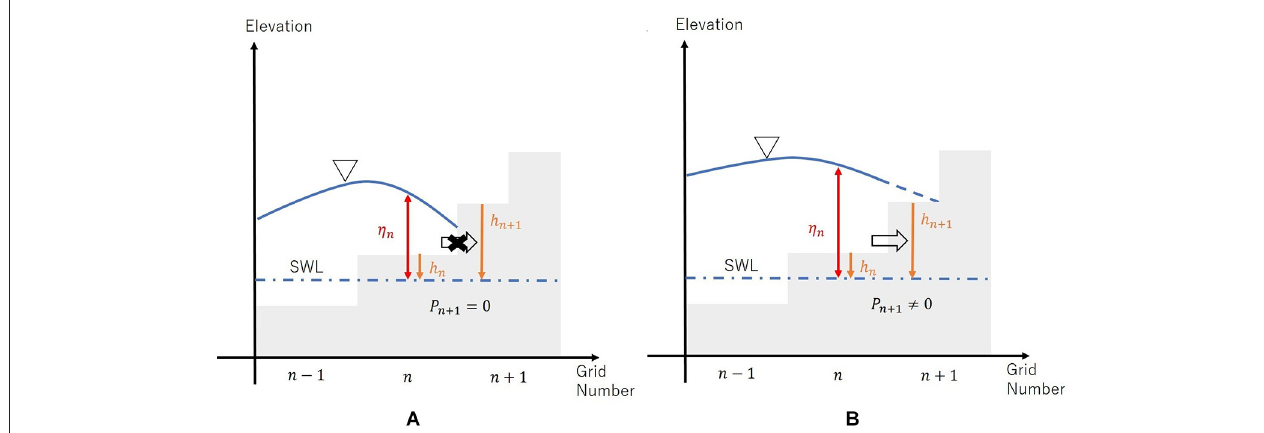
FIGURE 1 | Schematic view of the inundation scheme [ (A) the case grid n + 1 is not inundated, (B) the case grid n + 1 becomes inundated].